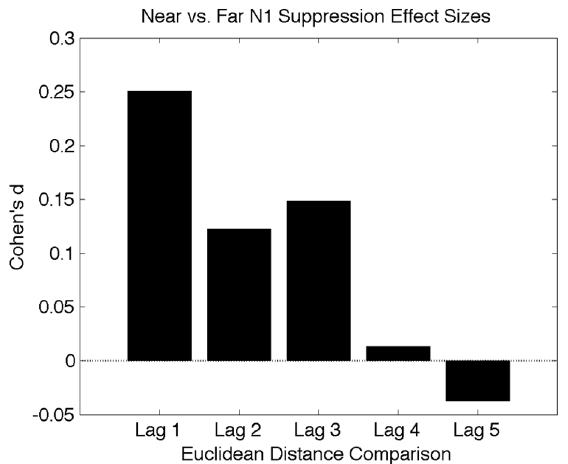
Figure 2. Cohen’s d effect sizes across lags. Cohen’s d effect sizes of Talk minus Playback N1 event-related potential (ERP) suppression for Near versus Far trials when compared in formant space to the most recent trial (Lag 1), the second-most recent trial (Lag 2), etc., through Lag 5. Although only Lag 1 Near vs. Far formant change had a significant effect on N1 suppression, there is a linear relationship between lag and Near vs. Far N1 suppression effect size ( p =.023).